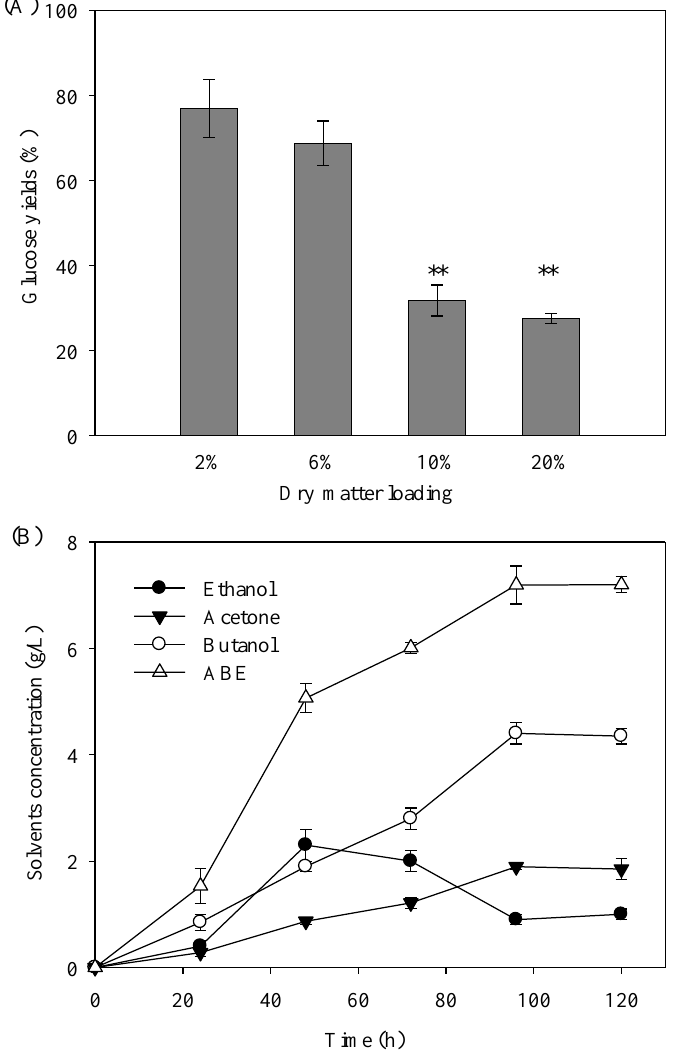
Figure 5. Acetone – butanol – ethanol (ABE) fermentation of enzymatic hydrolysate from fresh micro- algal biomass: ( A ) glucose concentration of fresh biomass with addition of different dry matter, the ** indicates the significant differences ( p < 0.01) of the 10% and 20% dry matter loading compared to 2% and 6%; ( B ) dynamics of solvent concentrations during fermentation. Table 4. The glucose concentrations in the hydrolysates derived from different dry matter loading.